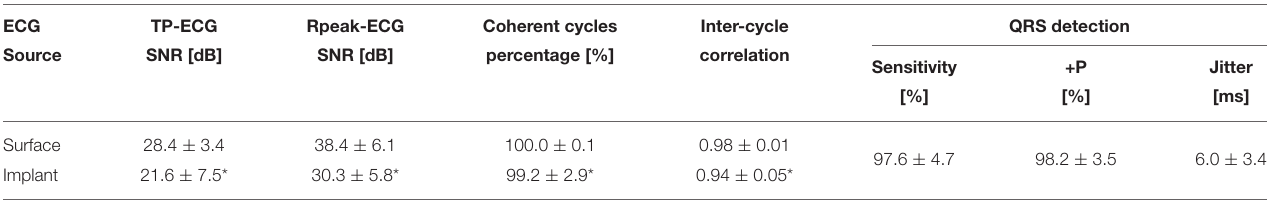
TABLE 1 | Validation of ECG recordings with a gold standard reference.